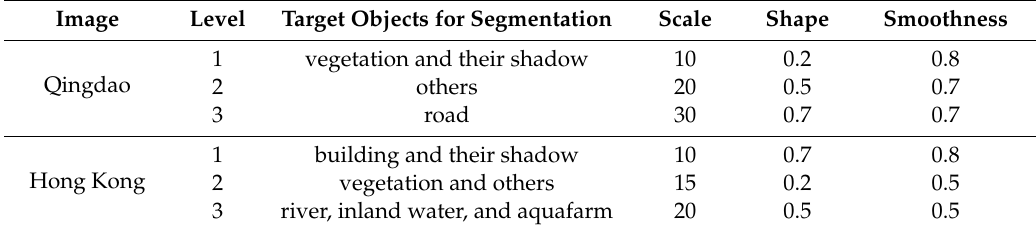
Table 2. Parameter settings in the generation of